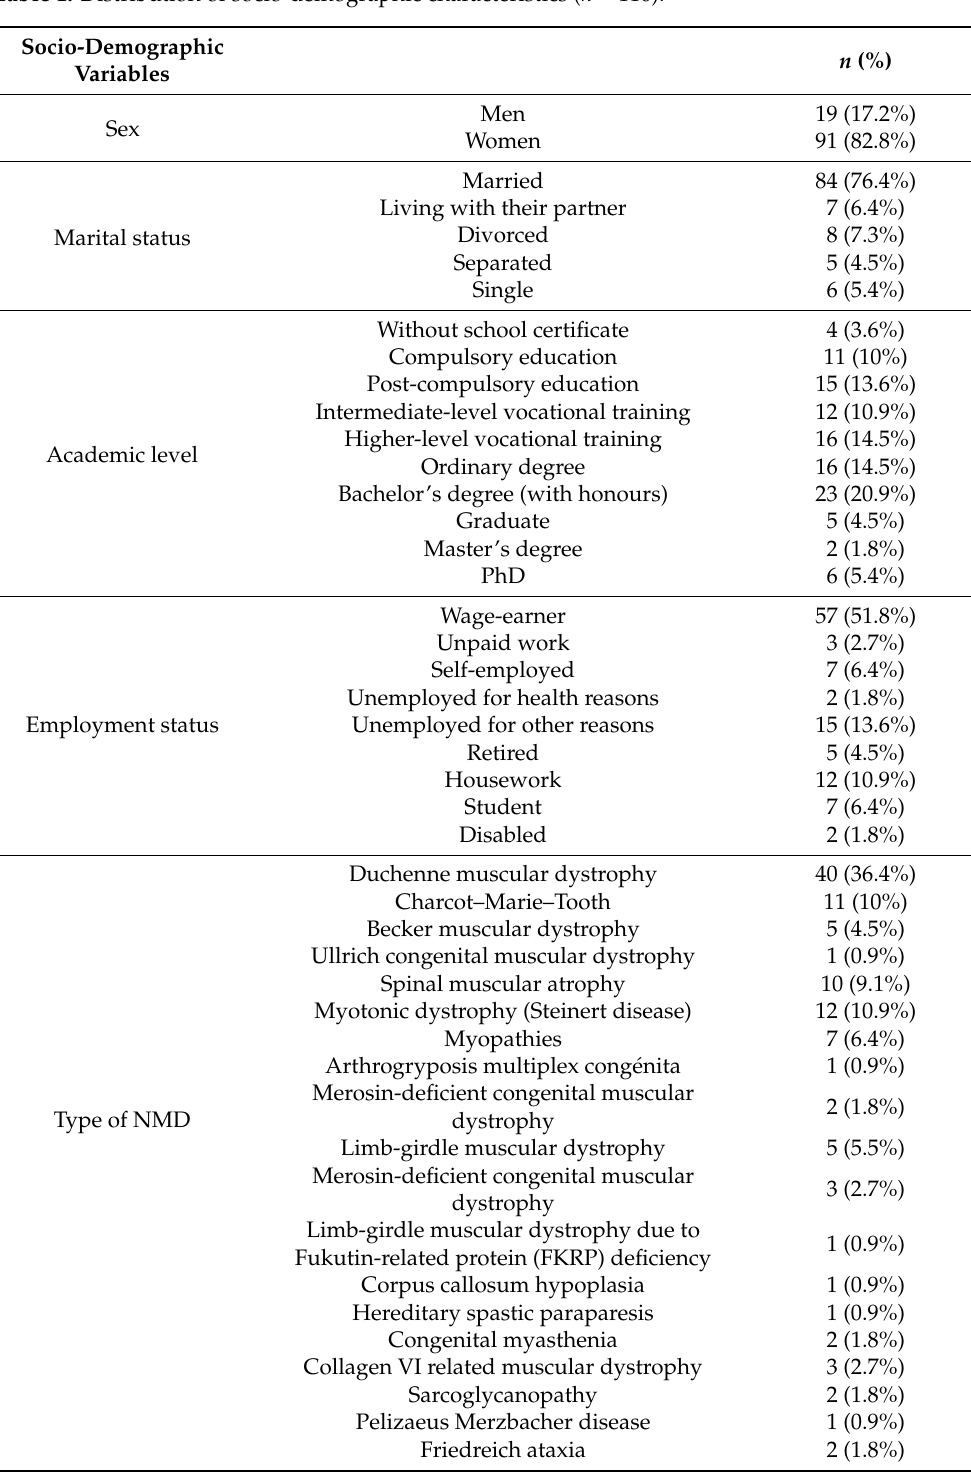
Table 1. Distribution of socio-demographic characteristics ( n =